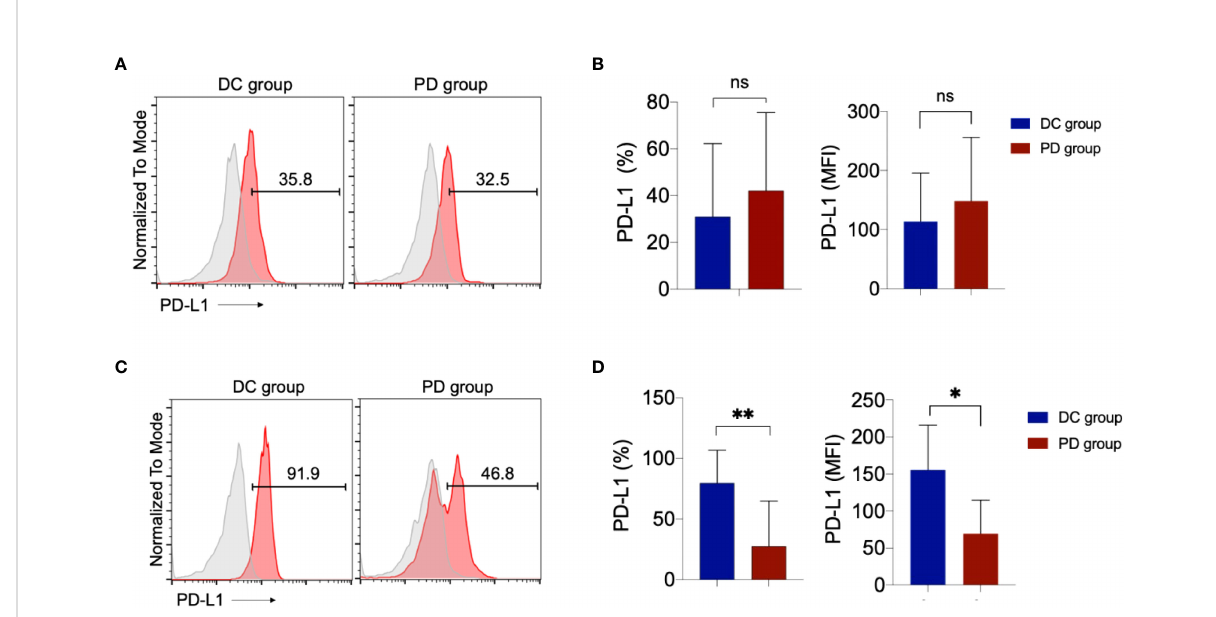
FIGURE 4 PD-L1 expression in NK cells. (A) Representative fl ow cytometry analysis of PD-L1 expression baseline. Histogram plots show the isotype control staining pro fi le (gray line) versus the speci fi c antibody staining pro fi le (red line). (B) PD-L1+ NK cell percentages and mean fl uorescence intensity (MFI) indicate the PD-L1 expression in NK cells after treatment. (C) Representative fl ow cytometry analysis of PD-L1 expression after treatment. (D) PD-L1+ NK cell percentages and MFI indicate the PD-L1 expression in NK cells after treatment. ns, no signi fi cance.**p<0.01.*p<0.05.